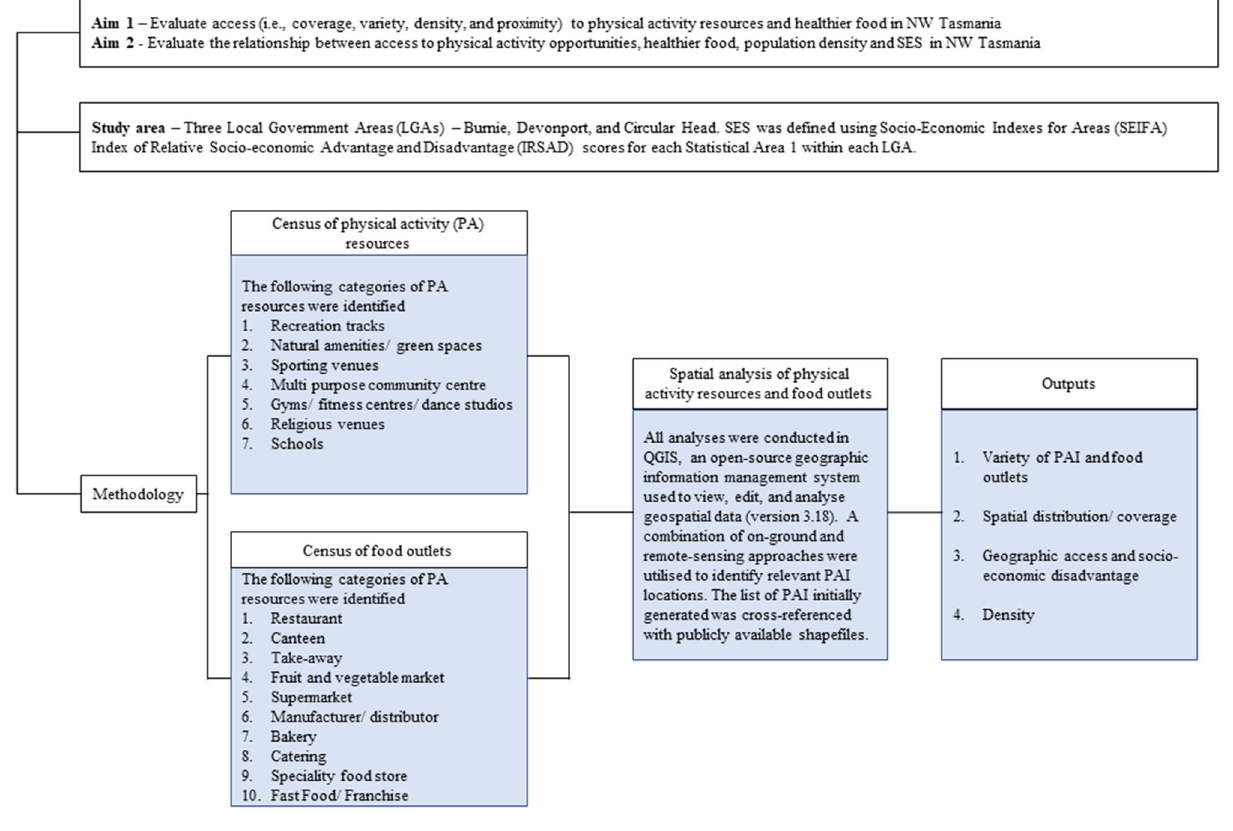
FIGURE 1 | Flow chart of study